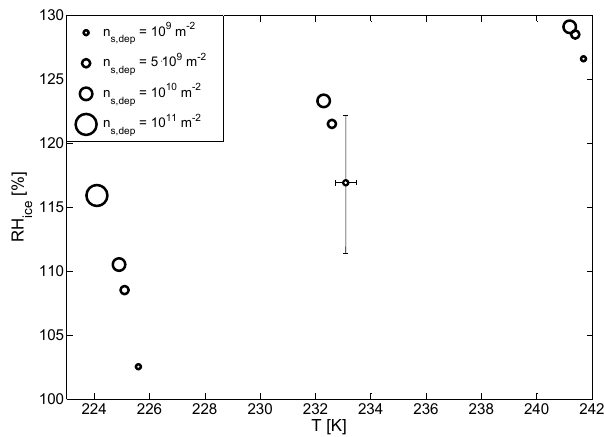
Fig. 8. Ice-active surface site densities for deposition nucleation n s , dep of volcanic ash particles (size of circles indicates value of n s , dep ) with respect to relative humidity over ice and